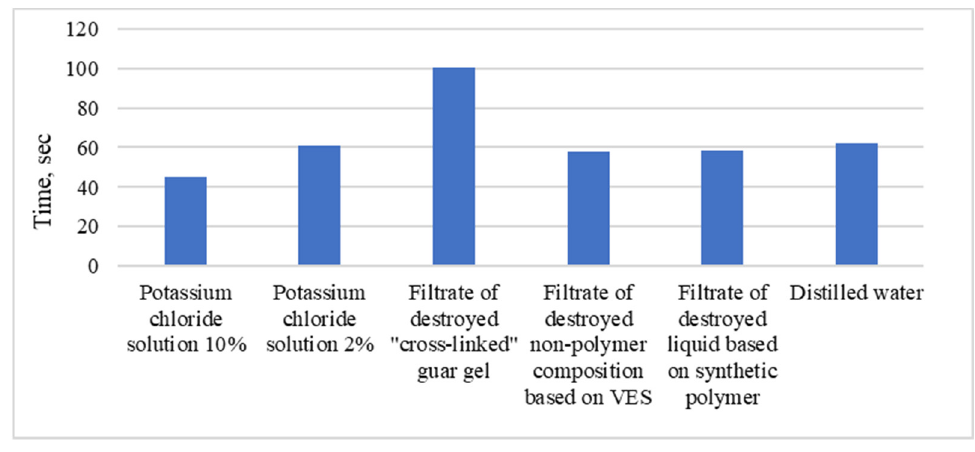
Figure 7. Viscosity measurements on the CST.